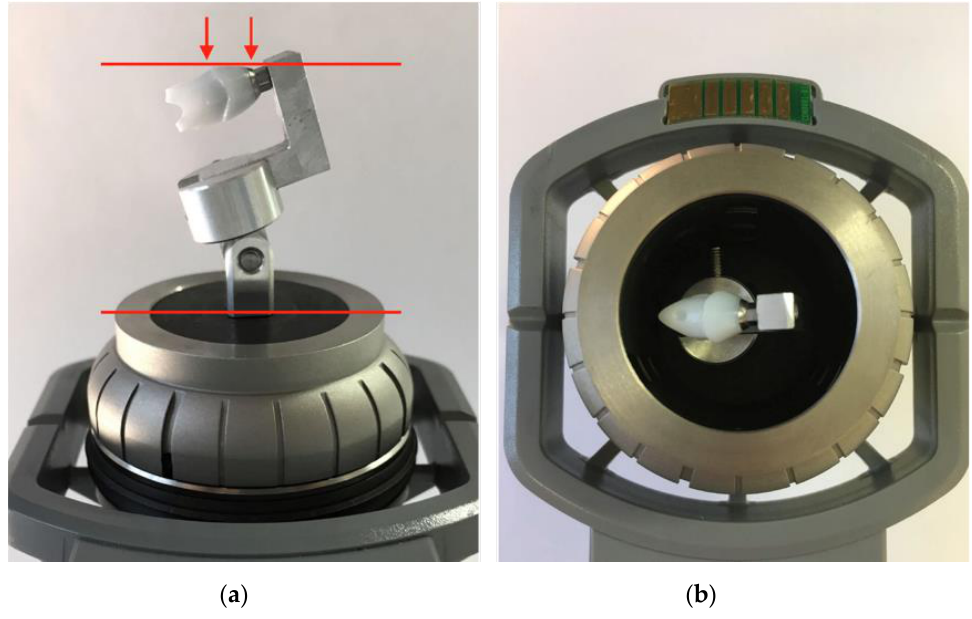
Figure 2. Test set-up: ( a ) Customized device and tilting turntable for exactly reproducible positioning of specimens during SEM; ( b ) specimen after lowering to optimum working distance.